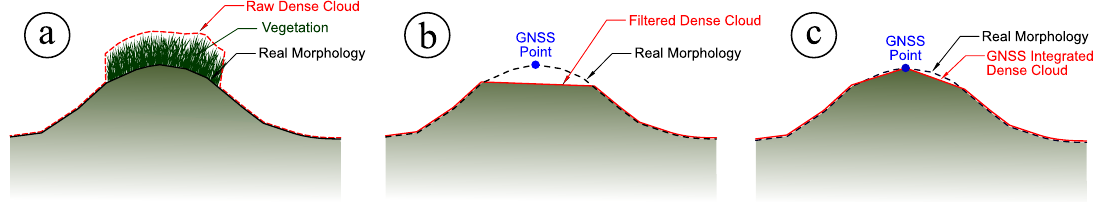
Figure 10. Schematization of the GNSS integration process by ( a ) filtering out the vegetation; ( b ) the survey of a point by GNSS and ( c ) the subsequent reconstruction of a more faithful shape.